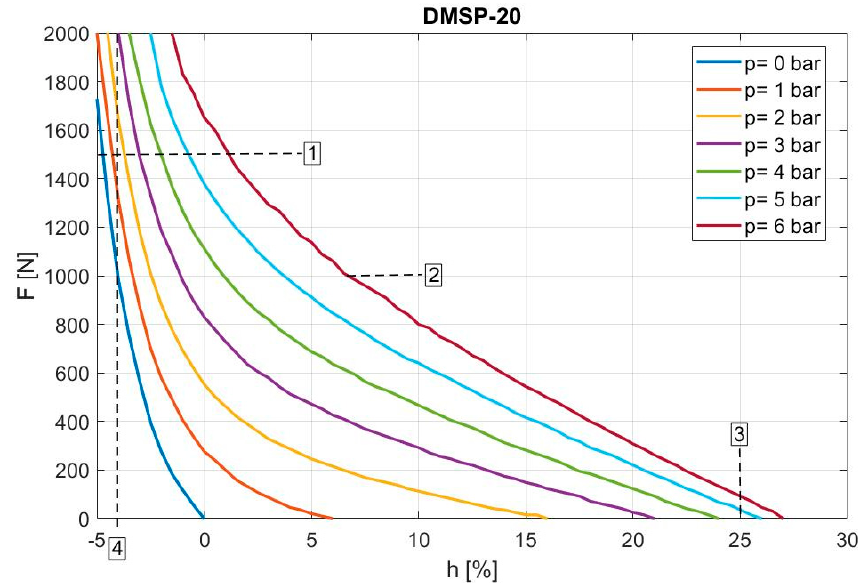
Figure 7. Operating range for the DMSP − 20 muscle [56].